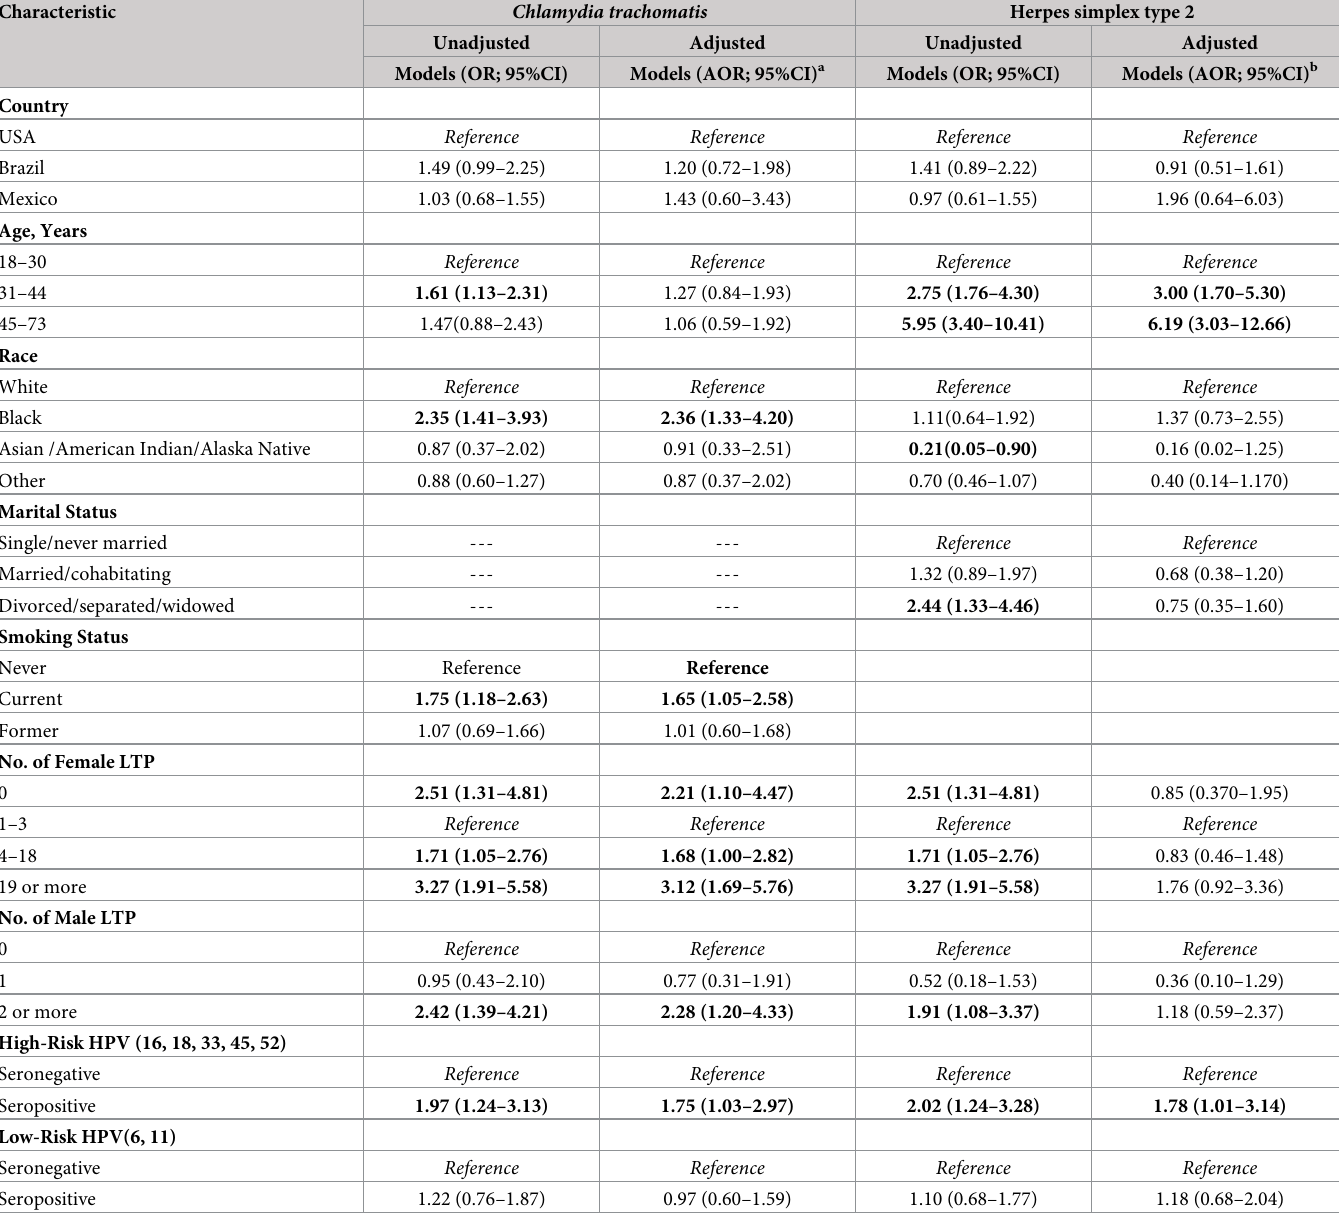
Table 3. Factors independently associated with seropositivity for Chlamydia trachomatis and herpes simplex type 2.